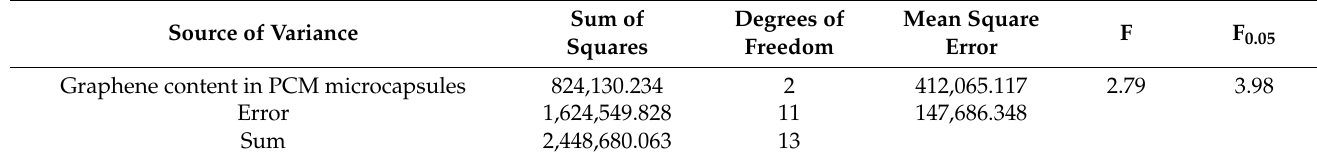
Table 9. Variance analysis of the bending failure strain results in the performed beam bending tests.